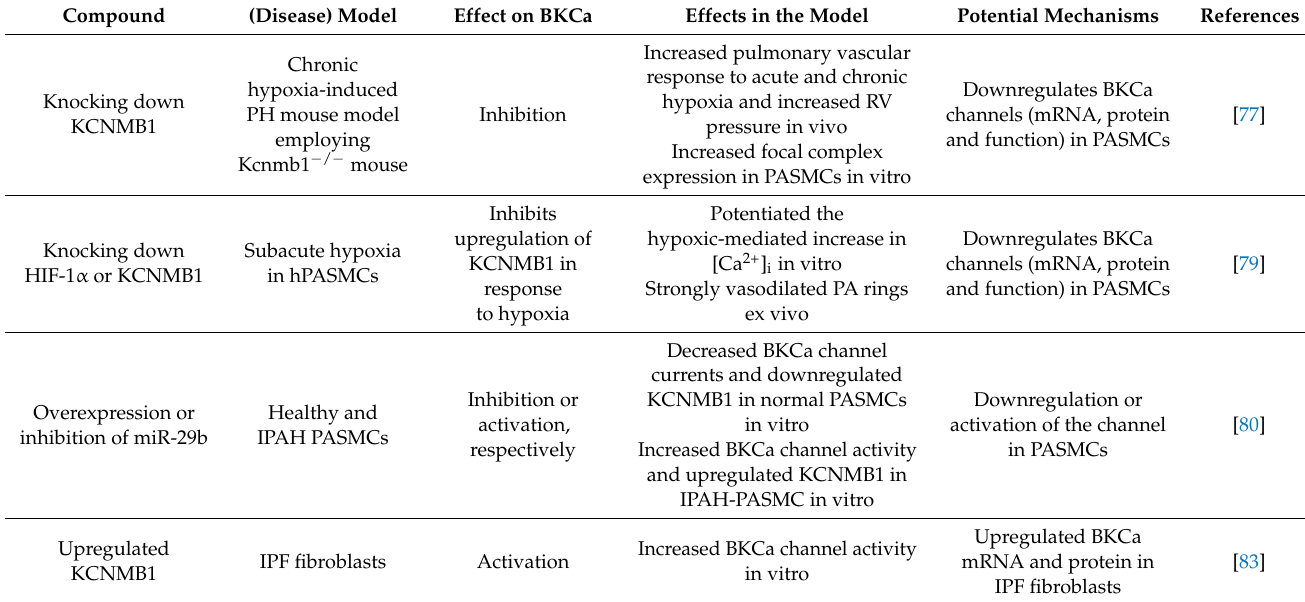
Table 2. Effect of interventions of BKCa β 1-sub unit in various disease